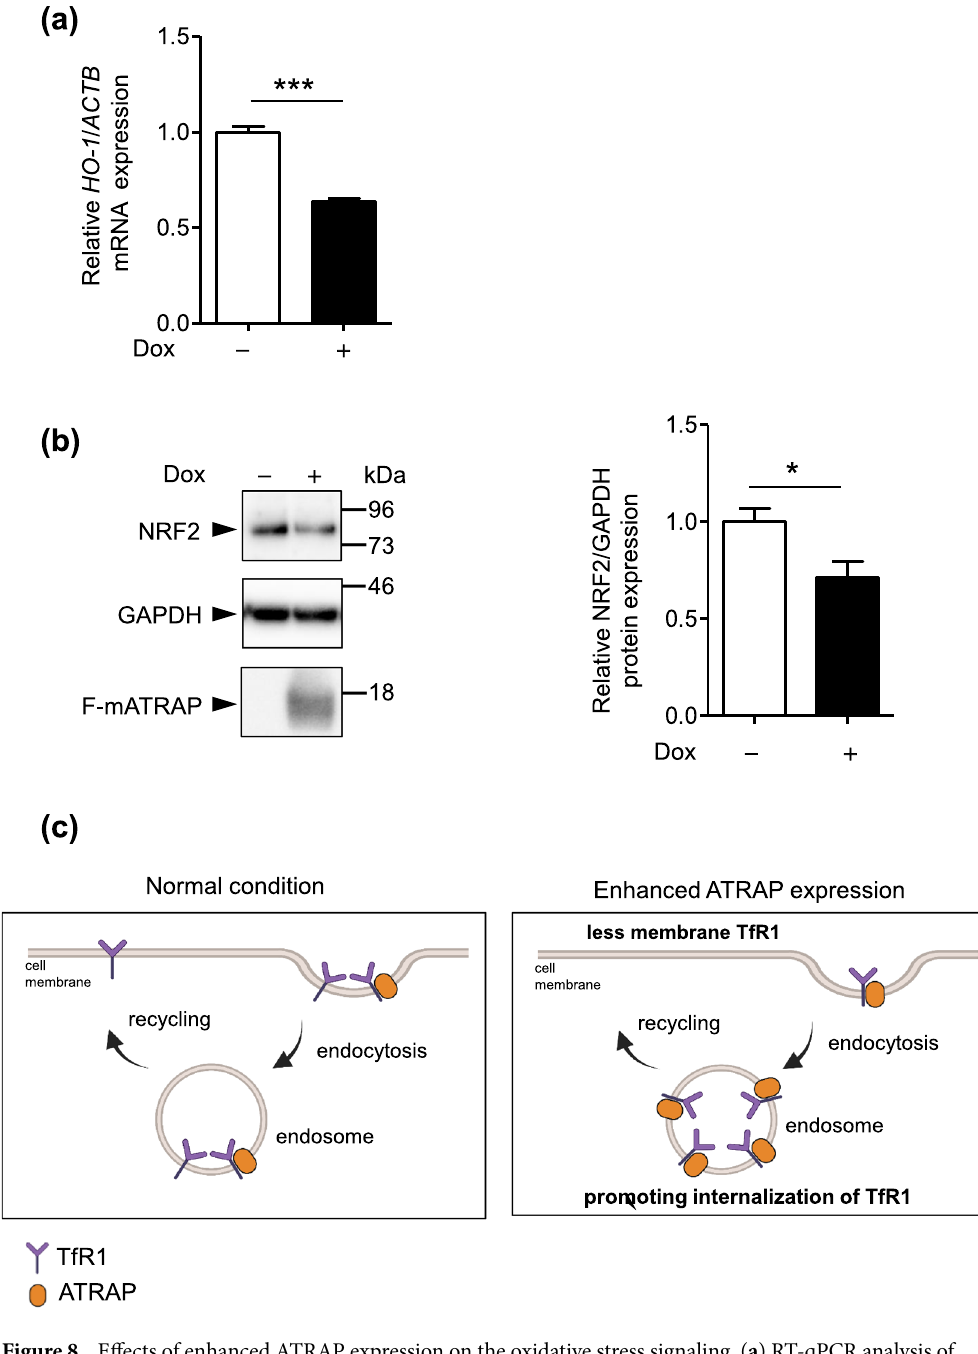
Figure 8. Effects of enhanced ATRAP expression on the oxidative stress signaling. ( a ) RT-qPCR analysis of HO-1 mRNA expression and ( b ) western blot analysis of NRF2 protein expression in Dox-inducible HEK293_F- mATRAP cells, with or without Dox treatment (Dox+/−). Quantitative results of RT-qPCR are shown. Unpaired t-test: *** p < 0.0001 vs. Dox+ cells. n = 3. ( b ) Representative western blot probed with indicated antibodies are shown. Quantitative results are shown in the right panel. * p < 0.05 vs. Dox+ cells. n = 6. ( a , b ) The data shown are presented as the mean ± SEM. ( c ) schematic representation of a model to explain TfR1 cellular trafficking under normal conditions or in the presence of enhanced ATRAP expression. This figure was created at